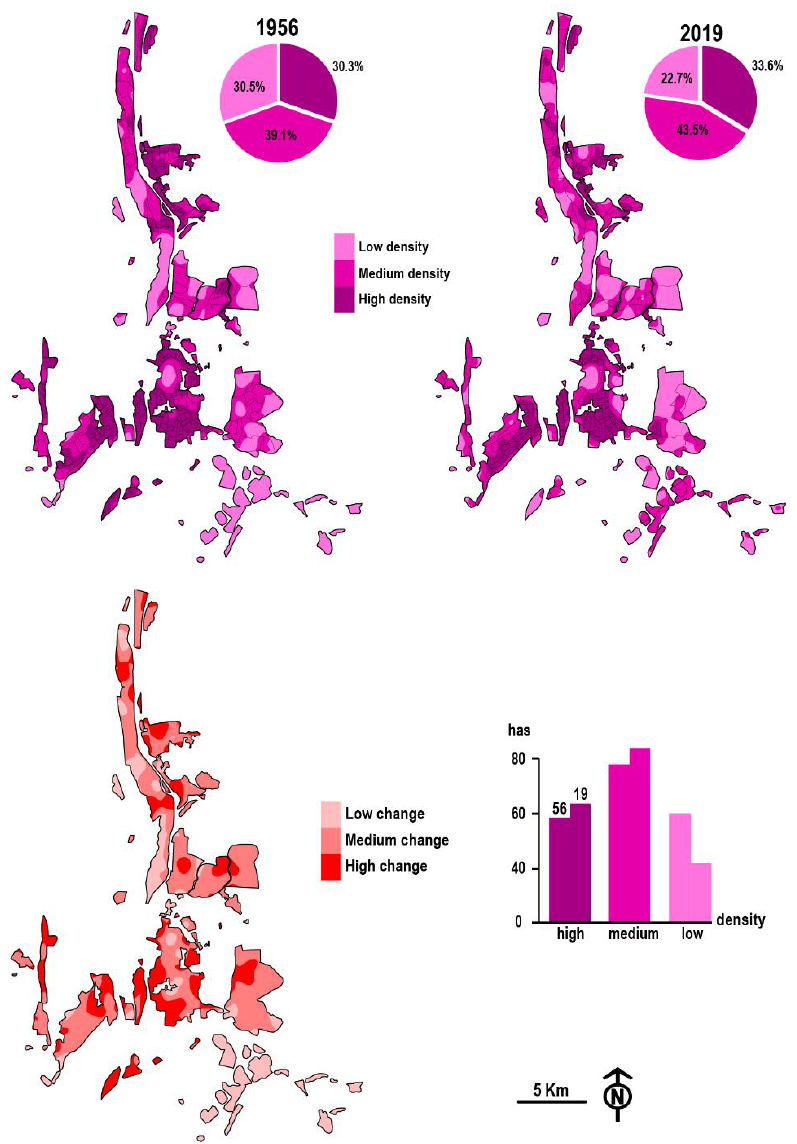
Figure 4. Density and changes in the Somosierra land parcels (1956–2019). Own